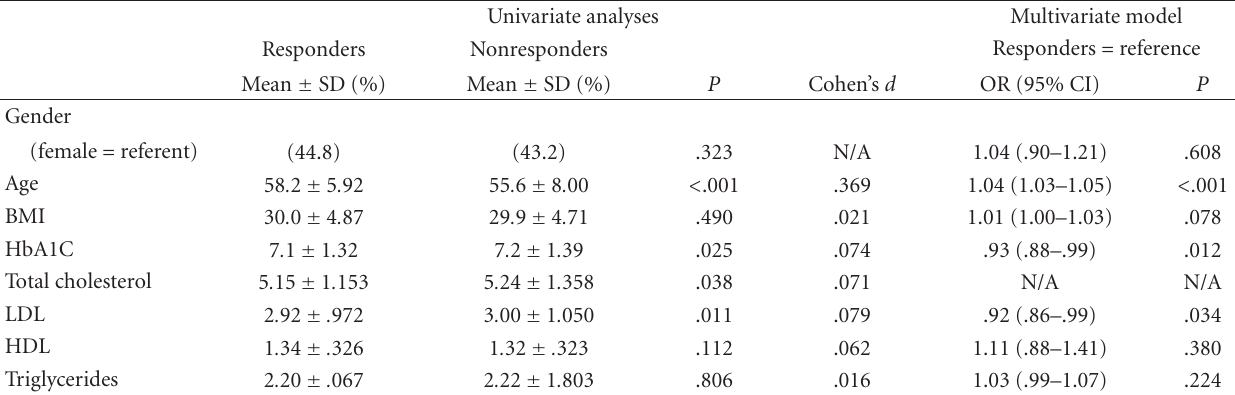
Table 1: Demographic and clinical variables in patients who responded and did not respond to depression screening.